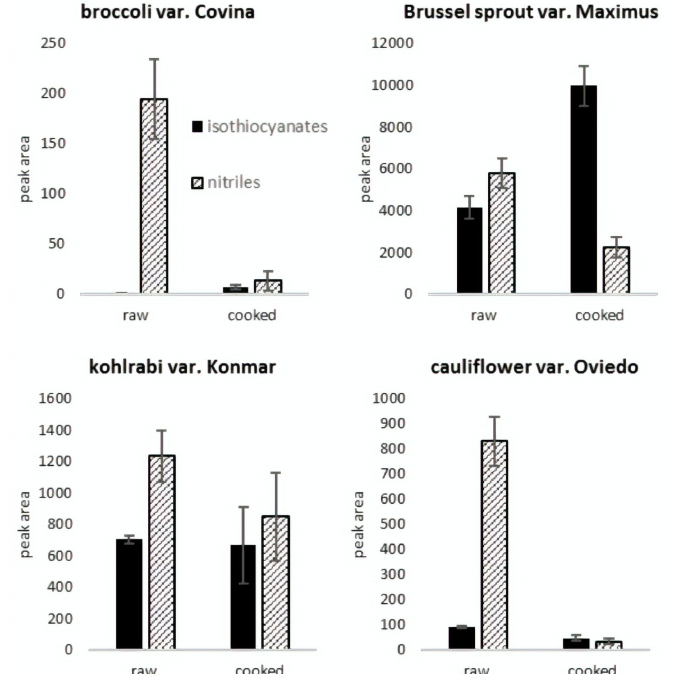
Figure 3. Proportions between isothiocyanates and nitriles in selected raw and cooked Brassica vegetables. The results are the mean of three replicates and the error bars show standard deviation. Amounts were expressed in total (sum of) peak